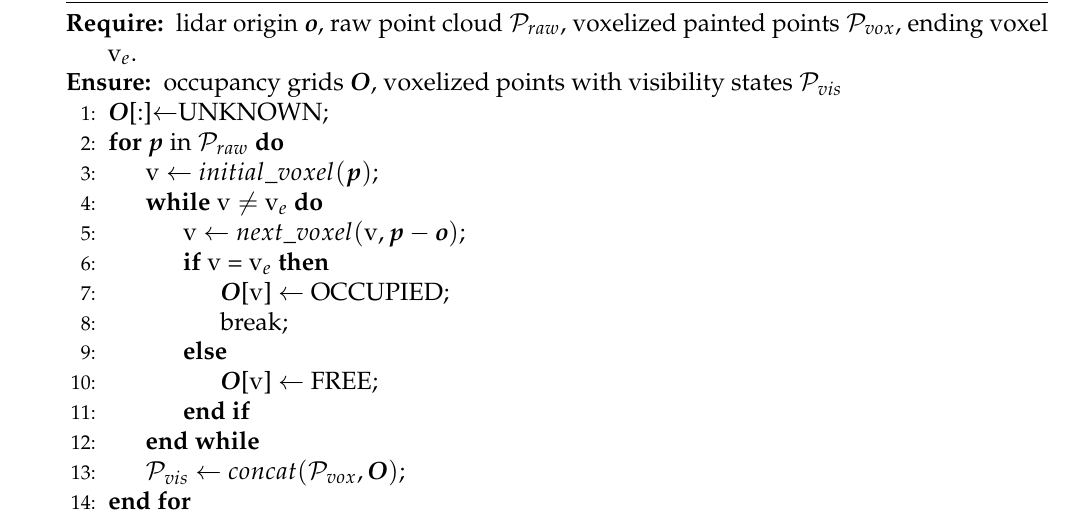
Figure 4. ( a ) A single sweep of LiDAR and the corresponding single-layer instantaneous visibility. The denotation of three visibility states are: occupied-space (red), unknown-space (light blue) and free-space (dark blue); ( b ) aggregated LiDAR sweeps and their single-layer superimposed temporal occupancy states. Color with increased saturation indicates a greater probability of occupancy state of the corresponding voxel. Algorithm 1 Vanilla voxel traversal